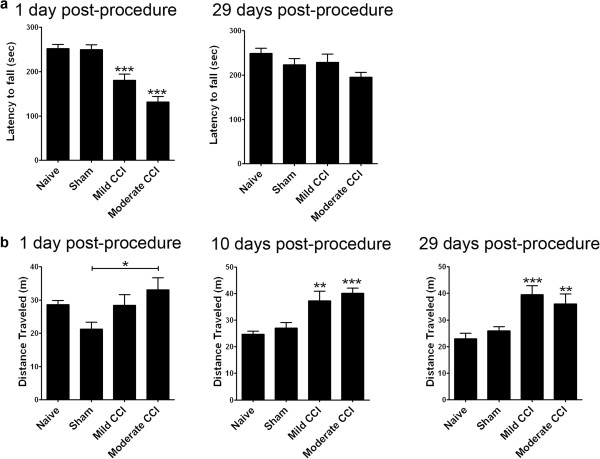
Unilateral CCI to the somatosensory cortex impairs sensorimotor coordination and triggers locomotor hyperactivity in adult mice. (a) CCI significantly impairs sensorimotor coordination at 1 day post-procedure as measured by the latency to fall from an accelerating rotarod (*** p < 0.001 moderate CCI versus naïve and mild CCI versus naïve). Accelerating rotarod testing at 29 days post-procedure reveals a recovery in sensorimotor coordination in moderate and mild CCI mice. The mean scores show a gradation of sensorimotor impairment with injury severity with moderate CCI mice performing worse than mild CCI. (b) CCI triggers locomotor hyperactivity in adult mice. There is no significant difference between CCI mice and naive mice at 1 day post-procedure but moderate CCI mice did travel significantly greater distances when compared to sham at this acute time point (* p < 0.05). Mild and moderate CCI mice travel significantly greater distances in open-field testing at 10 days post-procedure (*** p < 0.001 moderate CCI versus naïve, * p < 0.05 mild CCI versus naïve) and 29 days post-procedure (* p < 0.05 moderate CCI versus naïve, *** p < 0.001 mild CCI versus naïve). The performance of shams was not significantly different from naïve on either test at any post-procedure time point indicating these behavioral changes were due to the effects of cortical contusion. Data shown as mean ± SEM with n = 12/group, except open-field testing at 10 days post-procedure n = 10/group.